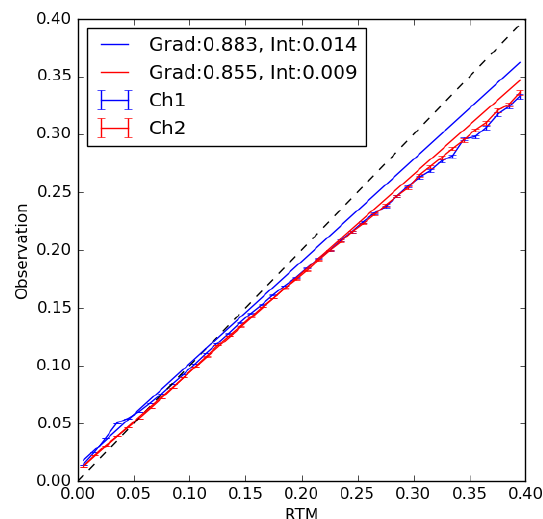
Figure 2. Observed reflectance as a function of RTTOV v11.3 radiative transfer model (RTM) reflectance for Channel 1, 0.6 µ m (blue) and Channel 2, 0.8 µ m (red). Joined data points show data binned at 0.01 in the RTM reflectance with associated error bars. Solid lines show a linear regression of the observed reflectance against the RTM in each channel. Dashed black line shows the 1:1 relationship. Legend shows the gradient (Grad) and intercept (Int) of the linear fits to the